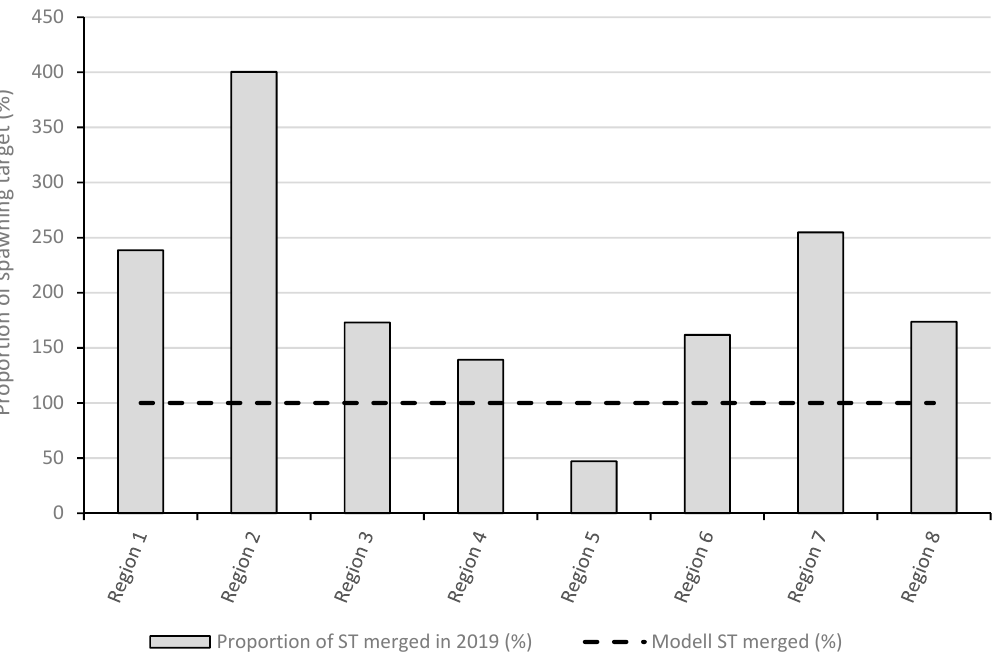
Figure 3. Estimated total biomass of spawning females merged for all rivers in each of the eight regions in 2019 expressed as a proportion (%) of the modelled spawning target (ST = 100%). (Data from [11]).